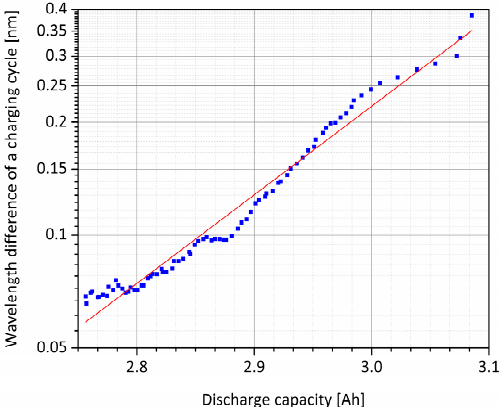
Figure 4. Comparison of the values of the ordinate axis discharge capacity (linear) and difference of the reflection wavelength (logarithmic) after the charge and discharge process of the integrated core Bragg grating sensor from Figure 3b. A continuous trend between loss of capacity and reduction of the total wavelength shift can be determined.